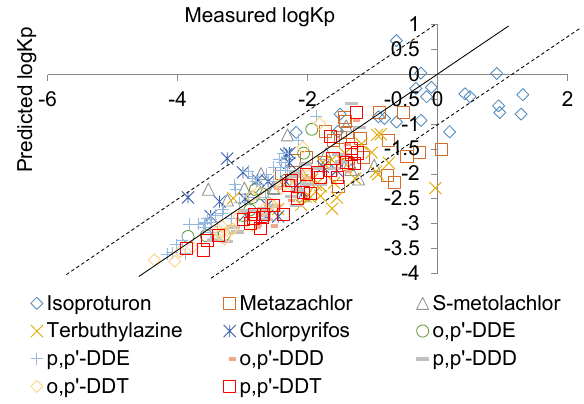
Figure 3. Comparison of predicted (see text, Eq. 3) and measured log K p of individual OCPs and